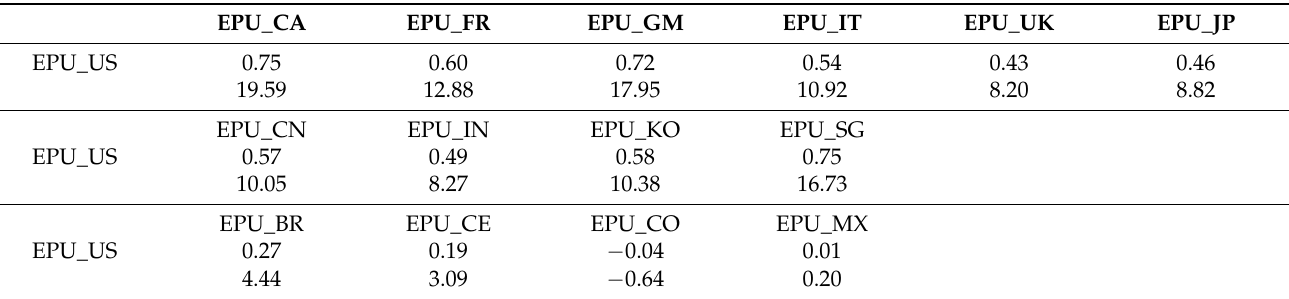
Table 9. Correlations of U.S. EPU and other global